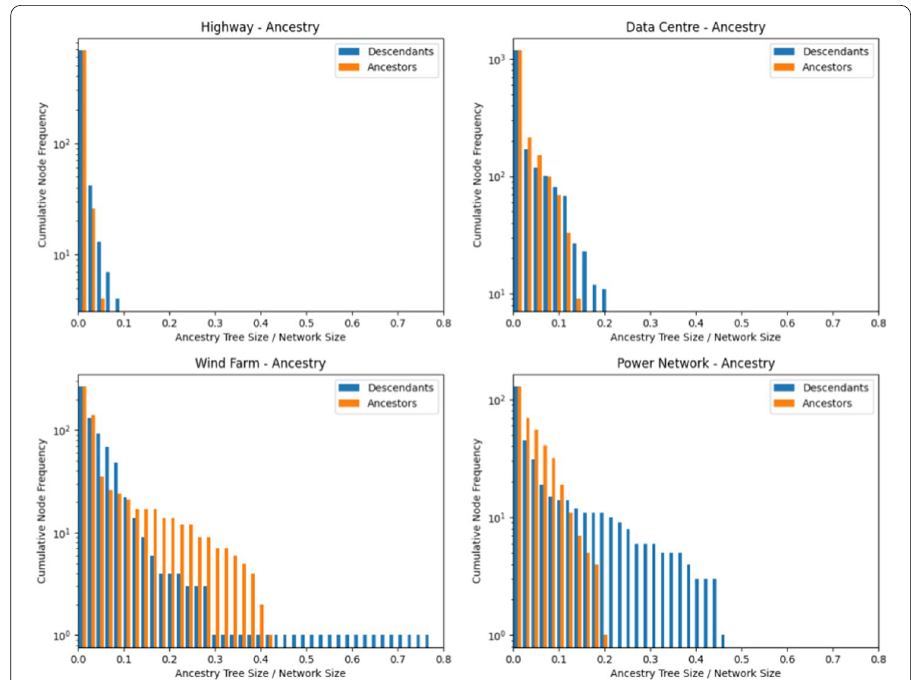
Fig. 1 Reverse cumulative frequency distribution of the fraction of descendants (blue) and ancestors (orange) over the total number of nodes. The distributions vary widely in terms of largest ancestry and descendancy fraction (from less than 0.1 for HW, to more than 0.7 for WF), showing different degrees of